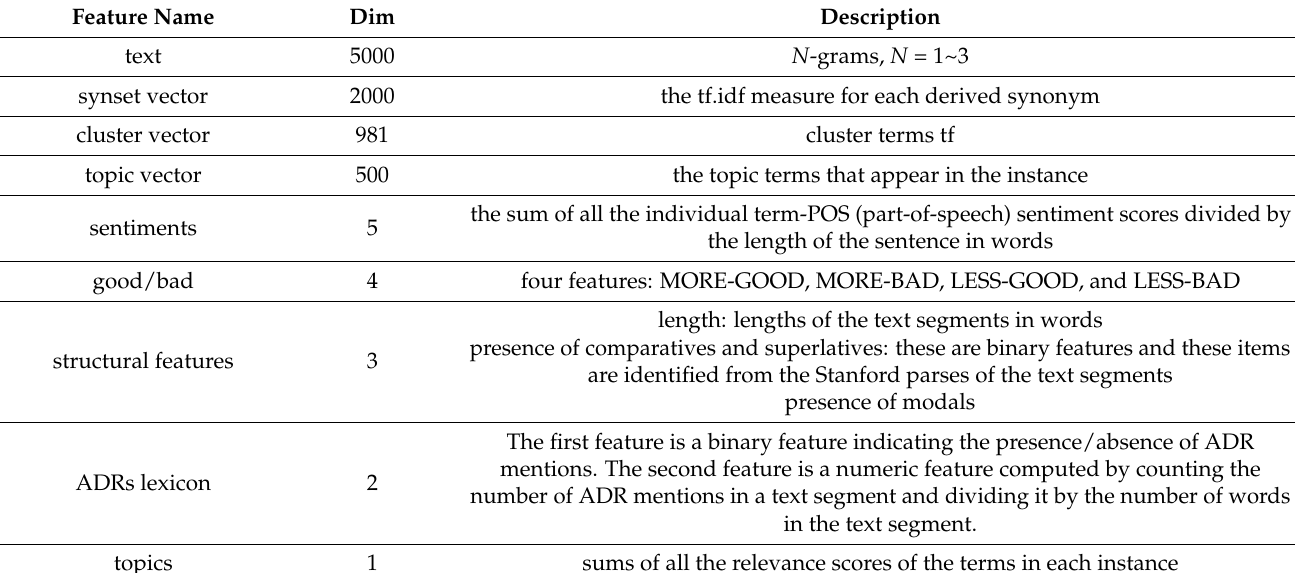
Table 1. The feature names extracted from the